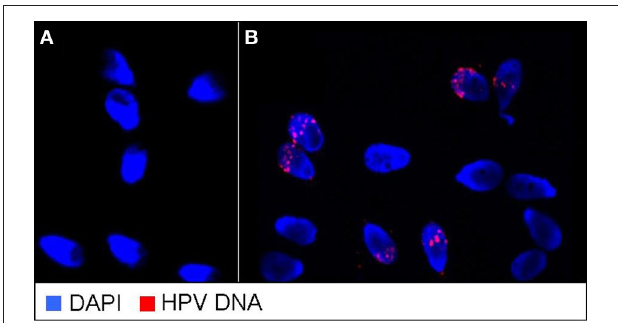
FIGURE 1 | An example of FISH analysis for HPV performed on infected semen samples from patients with testicular cancer. Red staining indicates the presence of HPV DNA. (A) Negative semen sample. (B) Infected semen